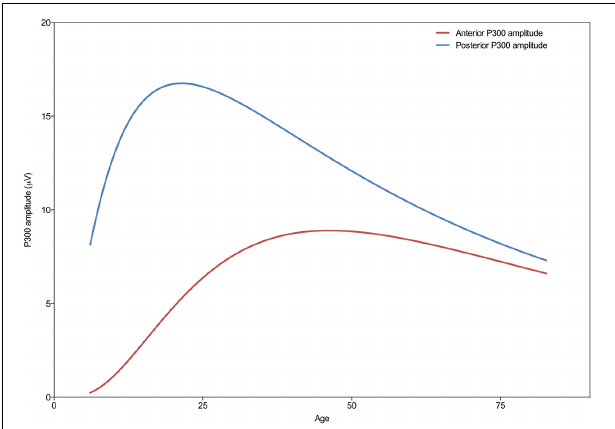
FIGURE 2 | Developmental trajectories of the frontal (Fz) and parietal (Pz) P300 amplitude across the lifespan. Note the different trajectories of the frontal and parietal P300 amplitude across the lifespan, where the parietal P300 peaks around the age of 21 years and then shows a progressive decrease, and the frontal P300 peaks around the age of 46 years, showing a less pronounced decrease in amplitude with increasing age.